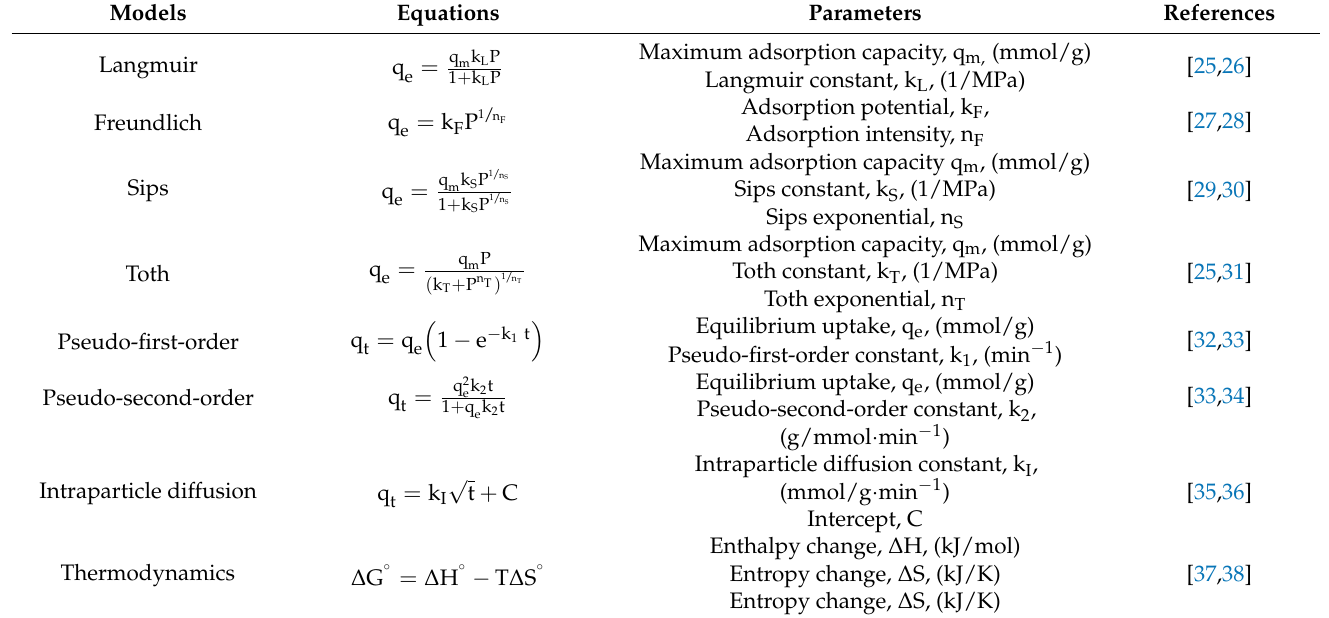
Table 1. The equations and parameters of the Empirical models employed in this